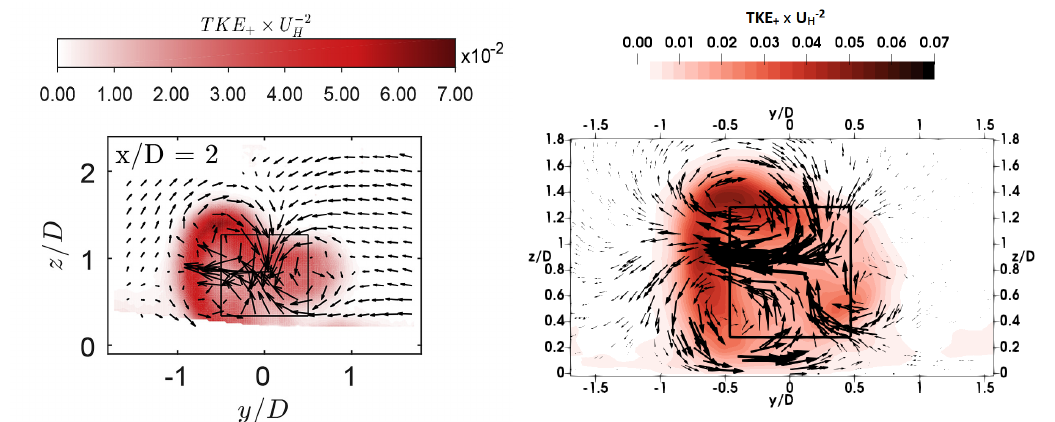
Figure 11. Contour of average TKE normalized by the upstream velocity U H /2 , 2.0 D downstream of the turbine: experimental data from [27] on the left and from the ALM-LBM simulation with Mesh No. 2 on the right. Average velocity vectors are projected onto the plane. Turbine footprint is delimited in black.